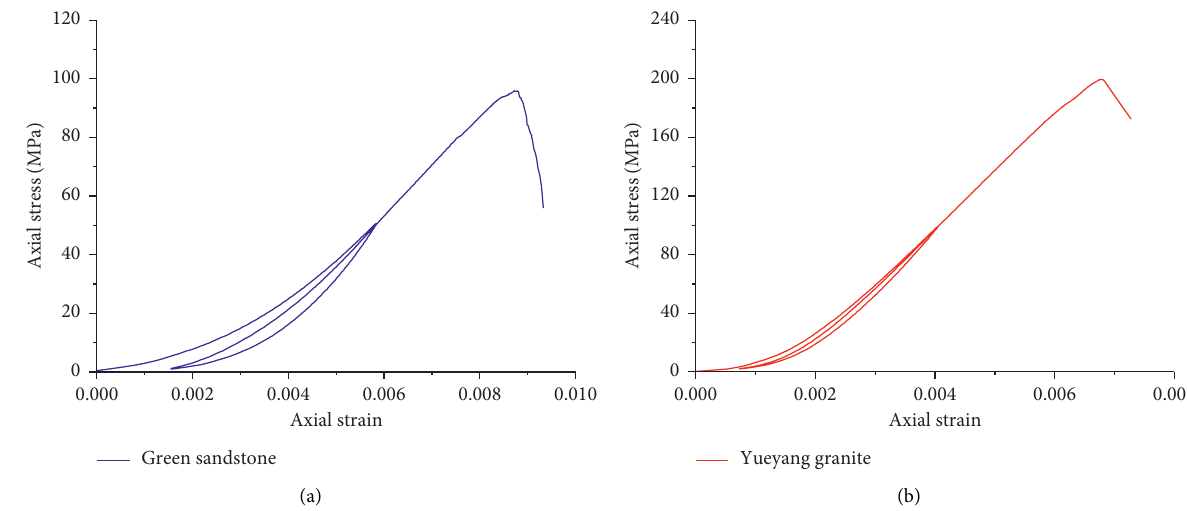
Figure 5: Stress-strain curve of the rock specimens in the single cyclic loading-unloading test at a setting stress level of 0.5 [7]. (a) Green sandstone; (b) Yueyang granite.